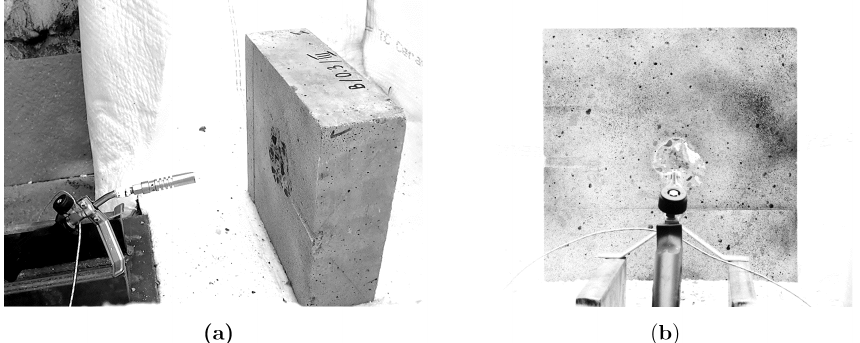
Figure 2. The experimental test stand and the concrete element with a size of 0.3 m × 0.3 m × 0.1 m: ( a ) Side view; ( b ) Front view.